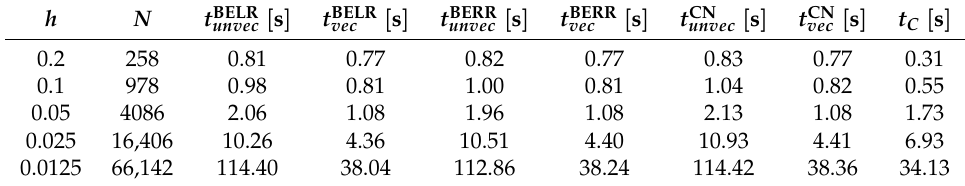
Table 4. The efficiency factor, C ef f , for different MATLAB-based sets of code and different space meshes with a fixed time step ( τ = 0.00125 ) .